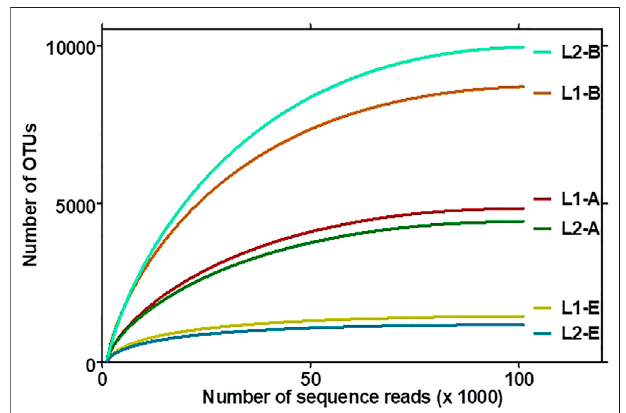
FIGURE 3 | Rarefaction curve of the operational taxonomic units (OTUs) of the archaeal (L1-A, L2-A), bacterial (L1-B, L2-B), and fungal (L1-E, L2-E) sequence reads associated with the sediments. Clustering of OTUs in sediments based on taxonomy-dependent clustering and taxonomy- based clustering (TDC-TBC), which fi rst identi fi ed sequences at species level using asimilarity-based identi fi cation method thathits against the EzBioCloud database (https://www.ezbiocloud.net/), and the sequences that cannot be identi fi ed(sequenceswith < 97%similarity)werethensubjectedtoaTBCtobe assigned OTUs. The con fi dence intervals of the curves were